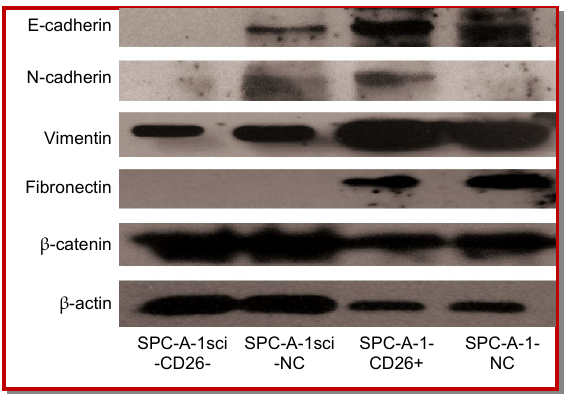
Figure 3: Effects of CD26 expression on EMT-associated mole- cules. visible upregulation of E-cadherin and N-cadherin was observed after CD26 was overexpressed. Expression of vi- mentin was higher in SPC-A-1-CD26+ and SPC-A-1sci-NC cells compared to other cells. The expression of fibronectin and (cid:451) - catenin was unchanged in infected cells